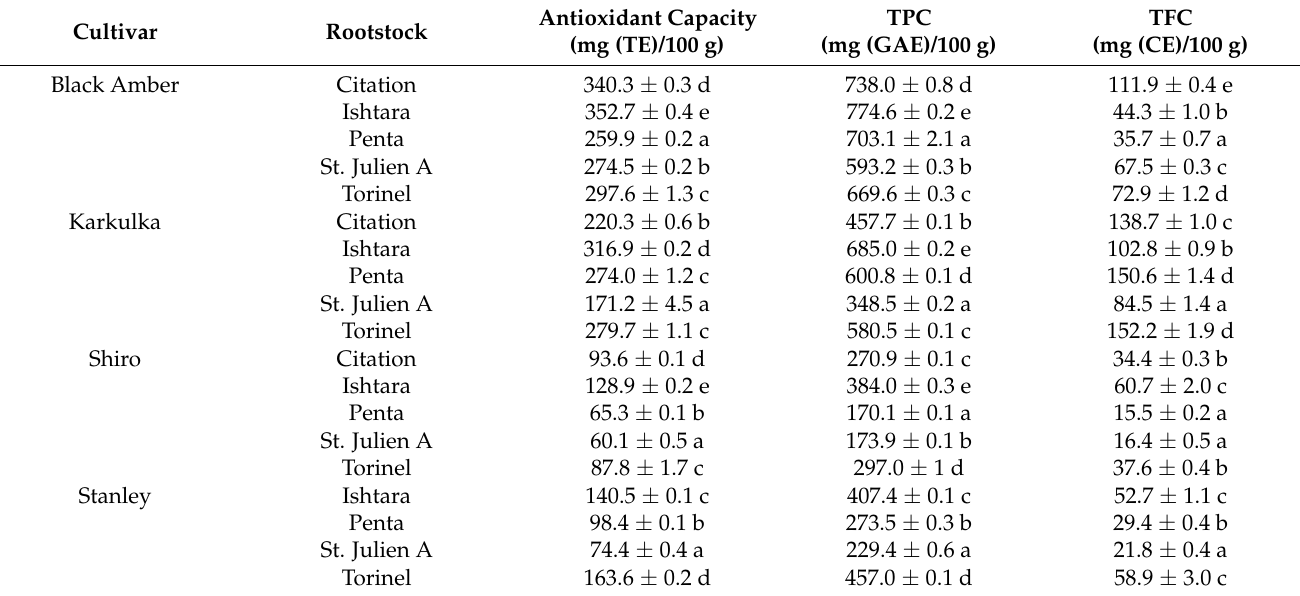
Table 3. The antioxidant capacity, TPC, and TFC of plum cultivars grown on different rootstocks.